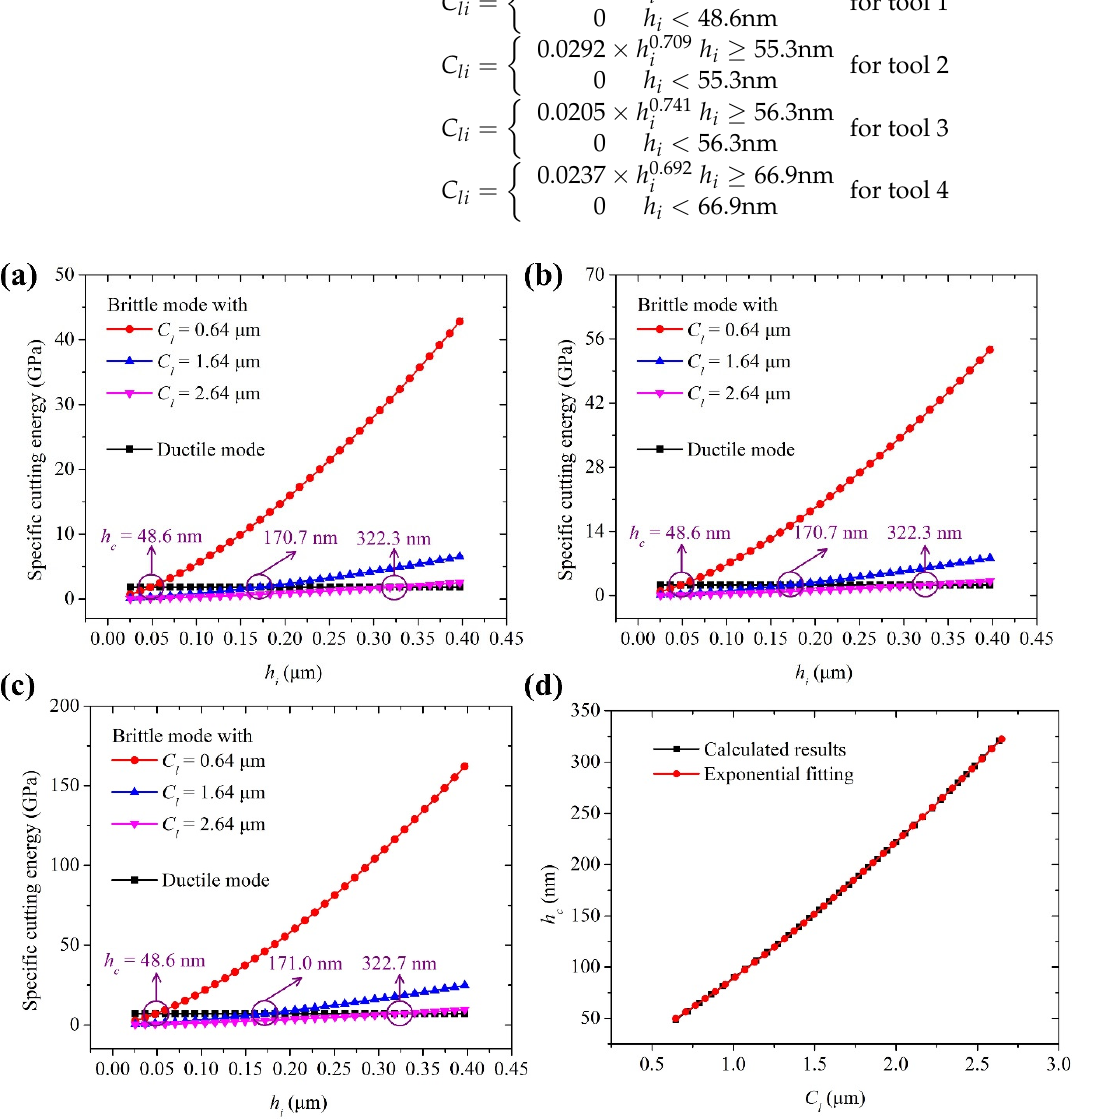
Figure 7. Variations of specific cutting energy with h i under different C l when ( a ) k 1 = 0.41, ( b ) k 1 = 4.1, and ( c ) k 1 = 41; ( d ) relationship between C l and h c for tool 1 when k 1 = 4.1. Note: h i : instantaneous UCT; h c : critical UCT; and C l : mean lateral crack depth.